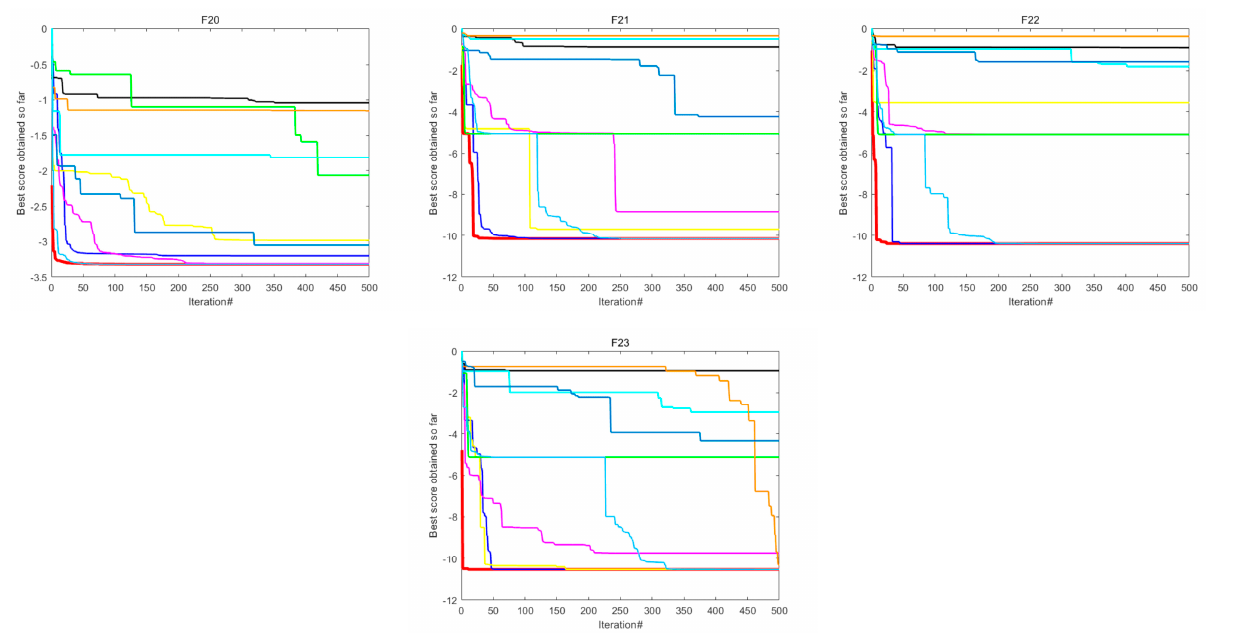
Figure 5. Convergence curves for the optimization algorithms for standard benchmark functions (F14–F23).